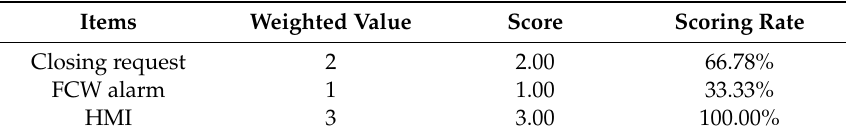
Table 8. The score in evaluation of